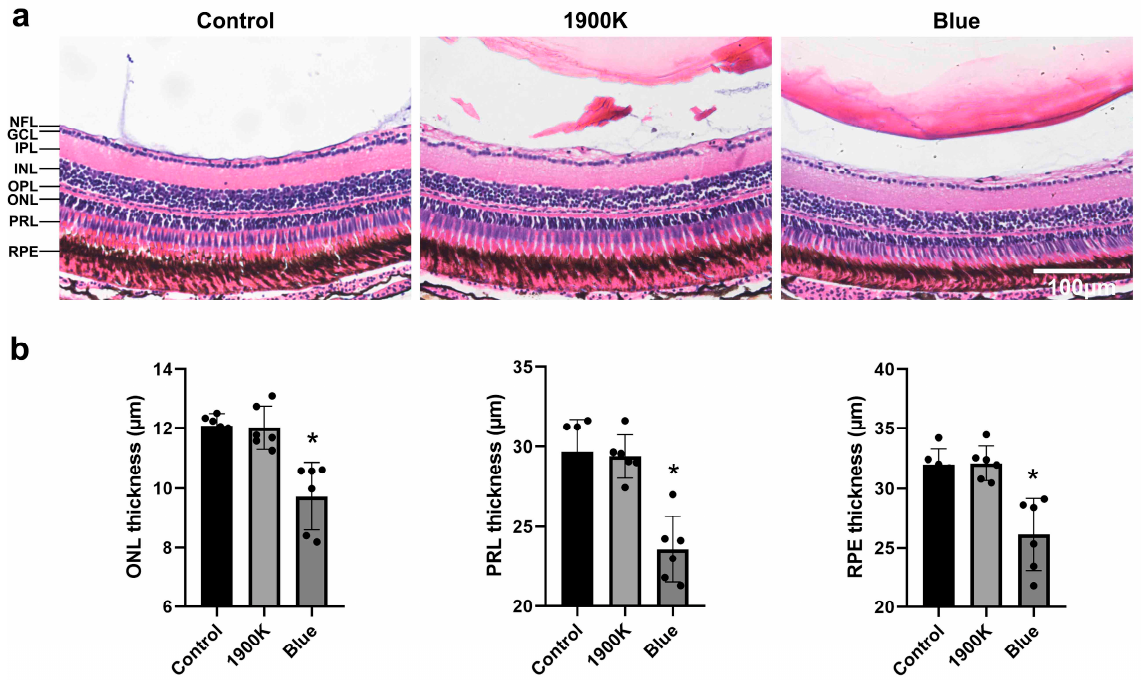
Figure 5. Irradiation with the 1900 K LEDs does not cause retinal damage in zebrafish. ( a ) Hema- toxylin and eosin stained retinal tissues of normal zebrafish and experimental zebrafish exposed under 3000 lux 1900 K LEDs and blue-light LEDs for 7 days. ( b ) Quantification of outer nuclear layer (ONL), photoreceptor layer (PRL), and retinal pigment epithelium (RPE) thickness of normal zebrafish and experimental zebrafish exposed under 3000 lux 1900 K LEDs and blue-light LEDs for 7 days. * ONL thickness significantly different from control group (one-way ANOVA: blue, p = 0.0005). * PRL thickness significantly different from control group (one-way ANOVA: blue, p = 0.0001). * RPE thickness significantly different from control group (one-way ANOVA: blue, p = 0.0006). The quantitative results of ONL, PRL, and RPE thickness per vertical column are presented as the mean ± SD ( n = 6 eyes in each group). Scale bar = 100 μ m. Abbreviations: NFL, nerve fiber layer; GCL, ganglion cell layerIPL, inner plexiform layer; INL, inner nuclear layer; OPL, outer plexiform